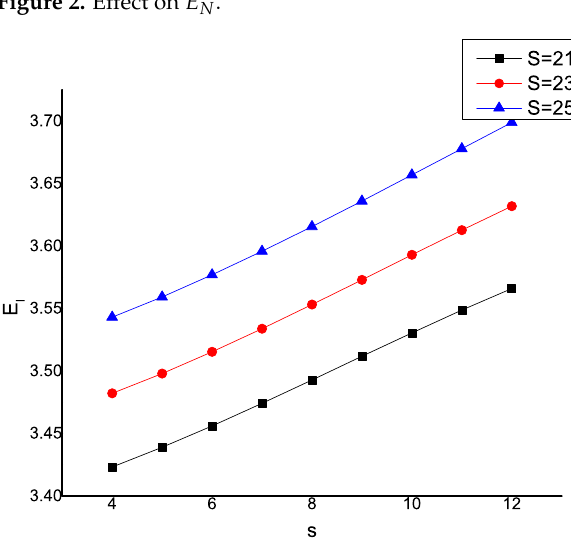
Figure 2. Effect on E N .